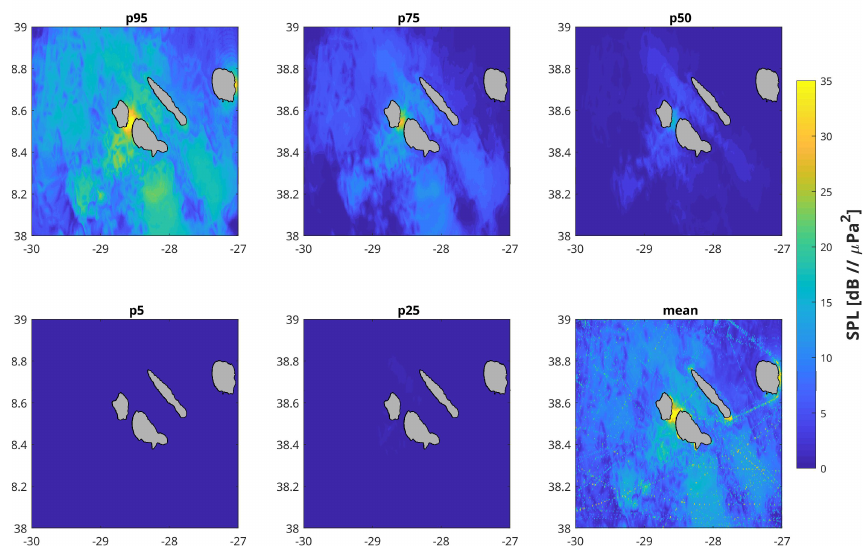
Figure 10. Instantaneous excess noise level (ENL) predicted percentiles and mean over the [40–1000]Hz band at 10m depth for the Azores central archipelago, in June 2018 with a spatial and time resolution of 500m and 10 min, respectively (axes: Latitude (y), Longitude (x) both in decimal arc